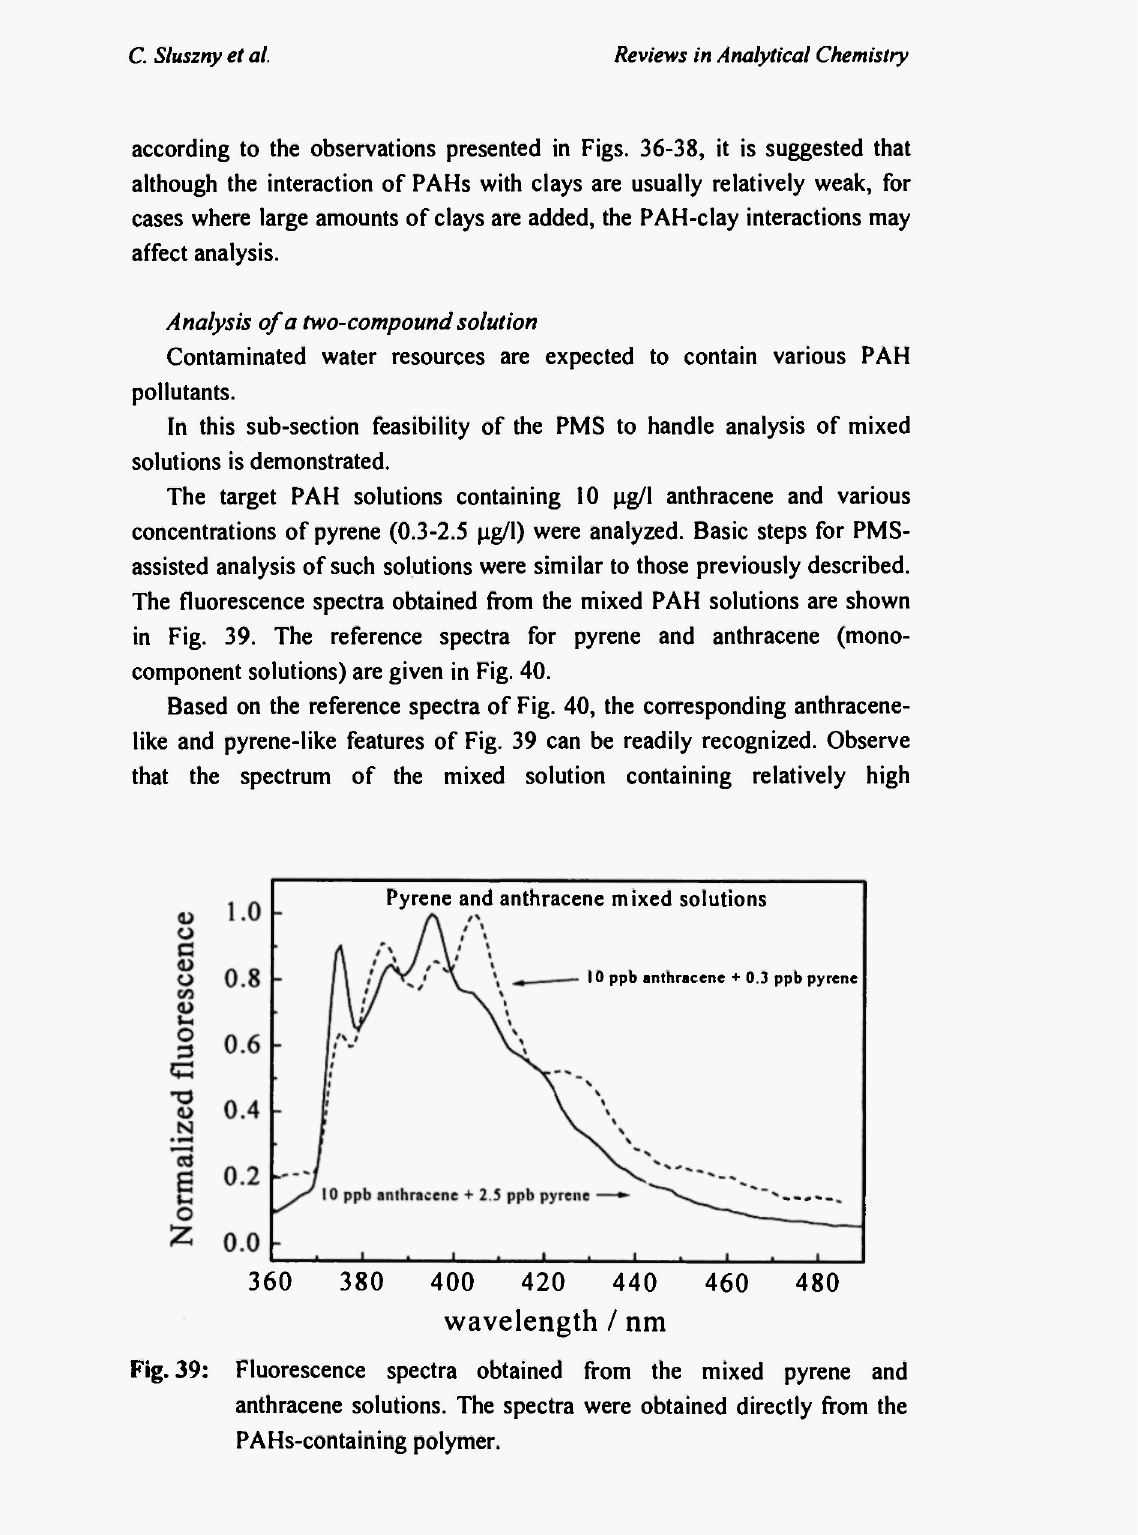
Fig. 39: Fluorescence spectra obtained from the mixed pyrene and anthracene solutions. The spectra were obtained directly from the PAHs-containing